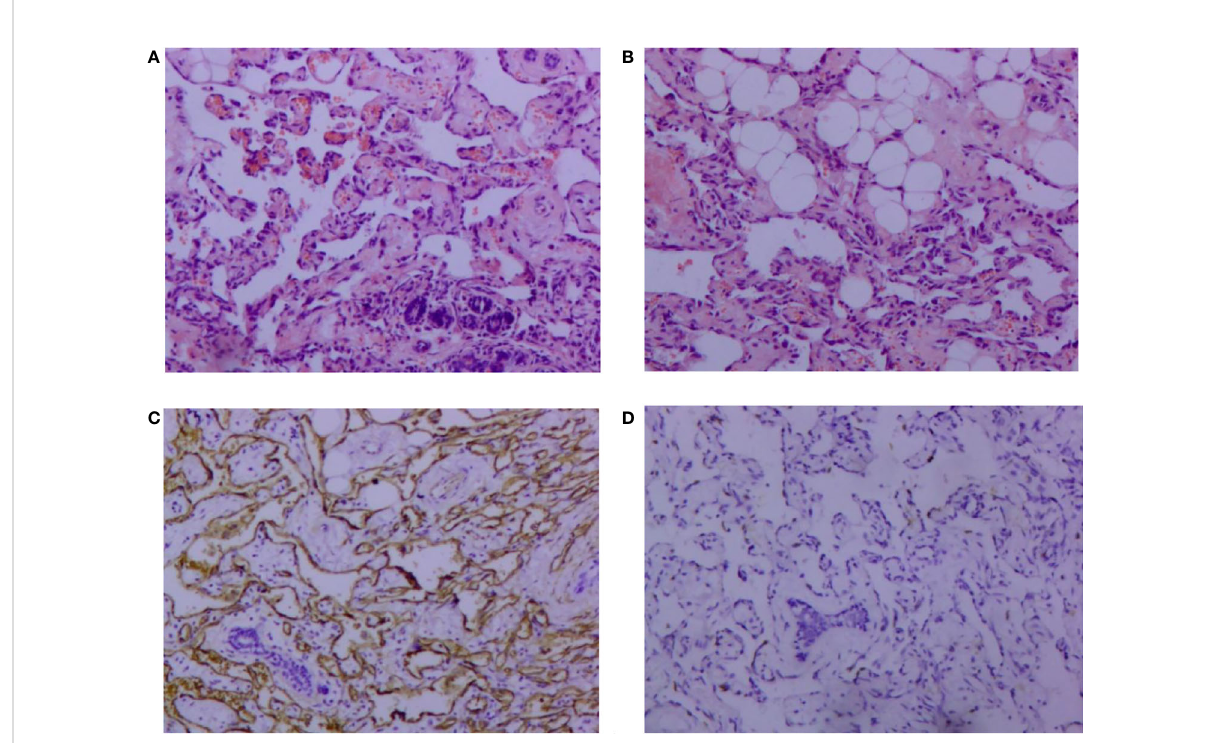
FIGURE 1 Pathological fi ndings of vascular neoplasms of the breast (hematoxylin and eosin, 100×). (A) Tumor cells in fi ltrating breast tissue and invading lobule tissue; (B) Tumor cells invading adipose tissue. Immunohistochemical image of vascular neoplasms of the breast (SP 100×); (C) positive immunohistochemical staining for CD34; (D) : positive immunohistochemical staining of